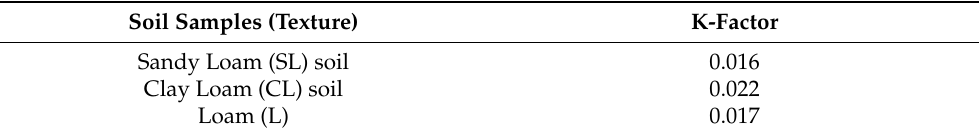
Table A9. Soil attributes of the Platana Dam basin and K-factor